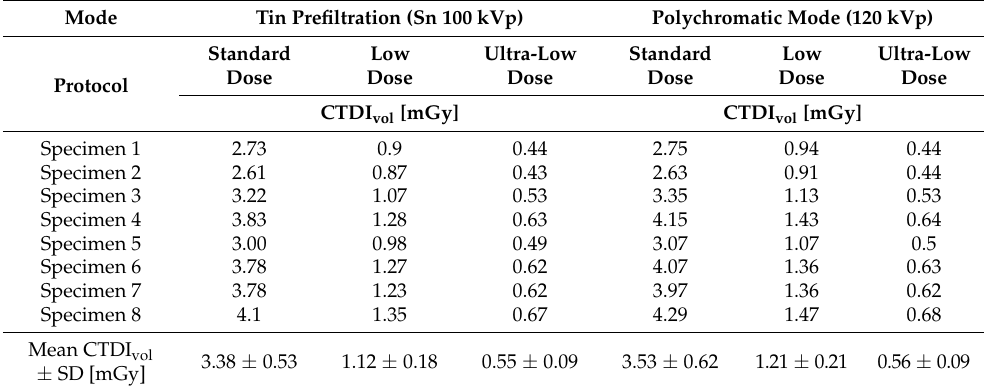
Table 2. Volume CT dose indices with automatic dose modulation and vendor-specific image quality settings for each of the eight cadaveric specimens examined in this study. Notably, polychromatic imaging was associated with higher radiation dose than low-dose scans with tin prefiltration.